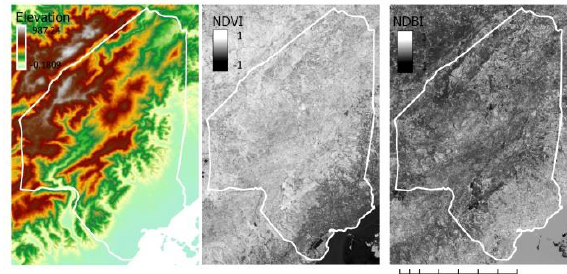
Figure 2. The elevation, and typical NDVI and NDBI data for Cebu